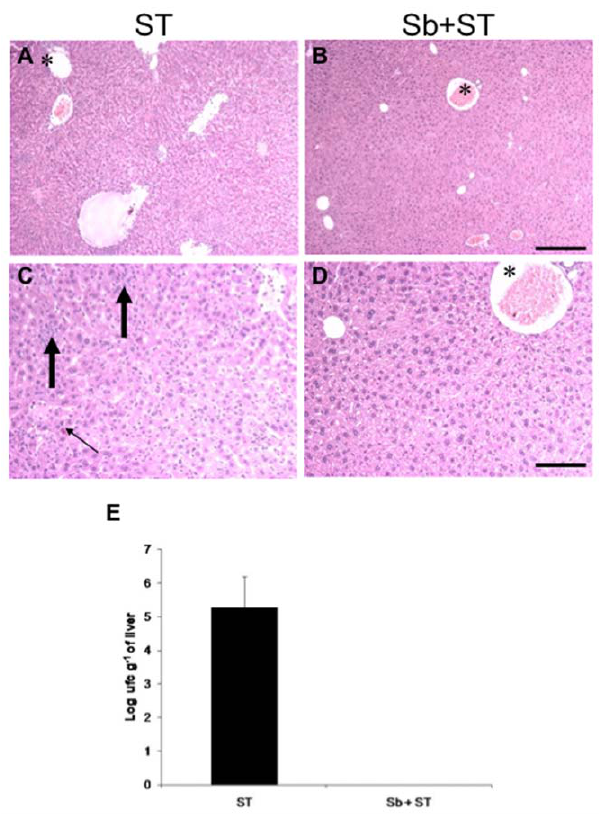
Figure 3. S. boulardii protects liver against S. Typhimurium lesions. Representative aspects of liver in ST (A, C) and Sb + ST (B, D) groups showing the portal spaces (*) and its surrounding parenchyma. In A and C there are diffuse small foci of inflammatory cells (large arrows) and degenerative changes (thin arrow) contrasting with architectural preservation and absence of significant changes in liver parenchyma of treated group (B, D). H&E, Bar =20 m m (A, B) and 10 m m (C, D). (E) S. boulardii prevents S. Typhimurium translocation to the liver. Translocation of S. Typhimurium to liver in experimental (Sb + ST) or control (ST) conventional mice challenged intragastrically with 4.0 log CFU of the bacteria. Determination was performed , 10 days after challenged (beginning of mortality). Vertical bars represent standard deviations of the means. N=10. ST ( S . Typhimurium), Sb ( S. boulardii ).